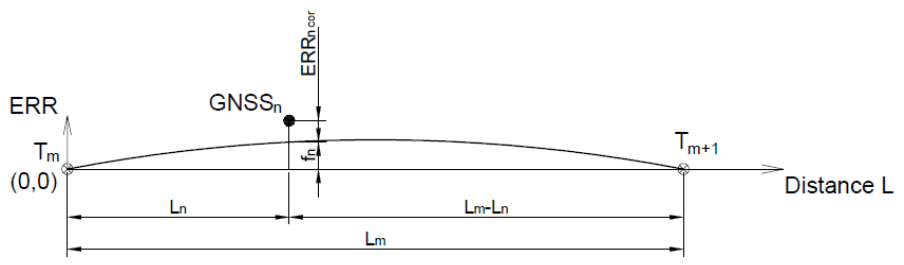
Figure 13. The influence of the versine on the value of error 𝐸𝑅𝑅 𝑐𝑜𝑟 .